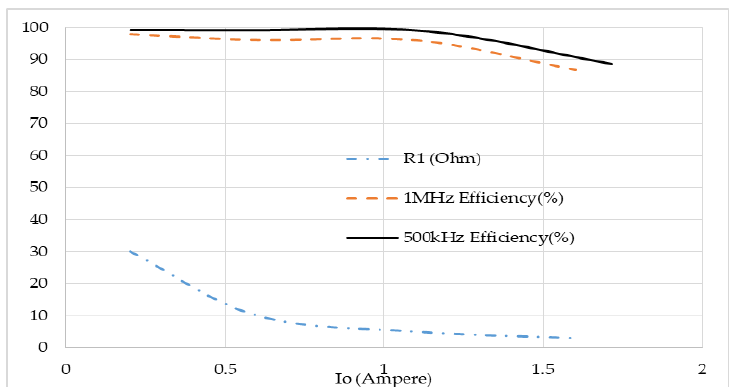
Figure 21. The power efficiency of the 500 kHz and 1 MHz switching frequencies with δ = 50% vs. different loadings. Table 4. Comparison among the experiment, simulation, and Equation (33).